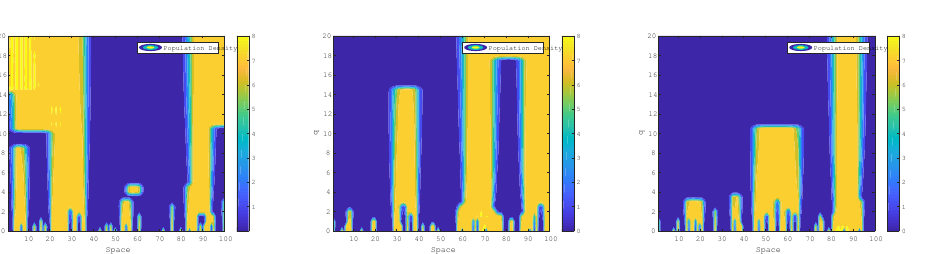
Figure 11. Same as in Figure 10 but for β = 7.